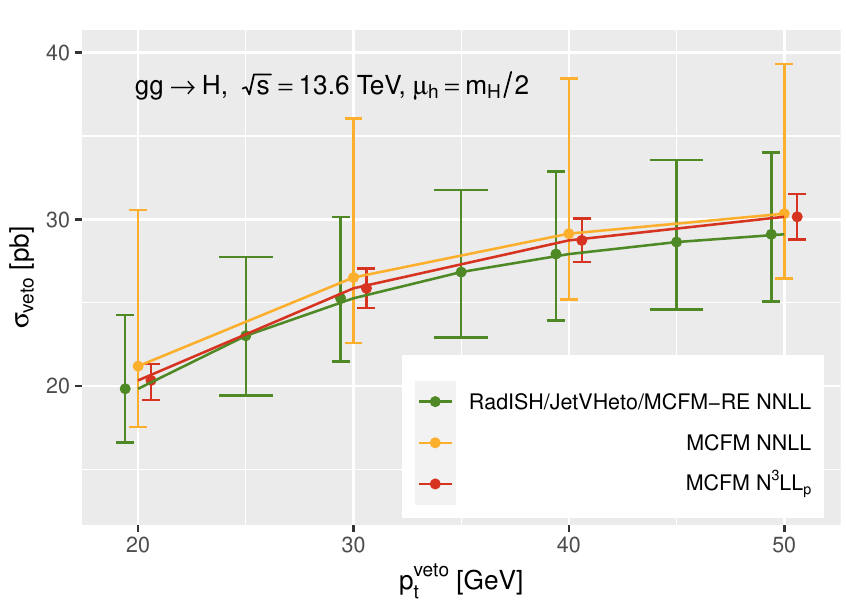
Figure 8 . Comparison of JetVHeto NNLL resummation with our NNLL and N 3 LL p results for non-decaying H